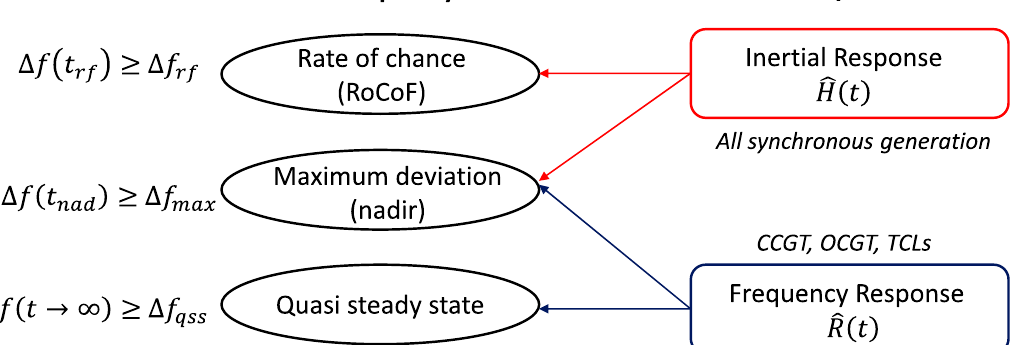
Figure 3. Interactions between ancillary services and conditions on the dynamic evolution of frequency following a sudden, large infeed loss.